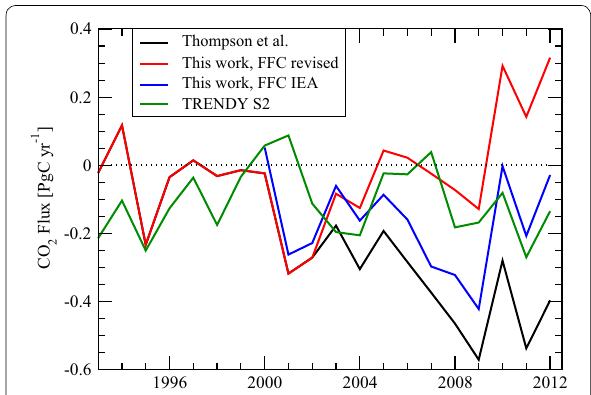
Fig. 8 Effect of FFC CO 2 emission increase rate on regional carbon budget of East Asia. The mean inversion flux of East Asia (from Thompson et al. 2016) is corrected a posteriori for revised China FFC CO 2 emissions using scaling from CH 4 inversion (This work, FFC revised) and that from the IEA (This work, FFC IEA). The mean CO 2 exchange simulated by TRENDY DGVMs (S2 simulation) are also